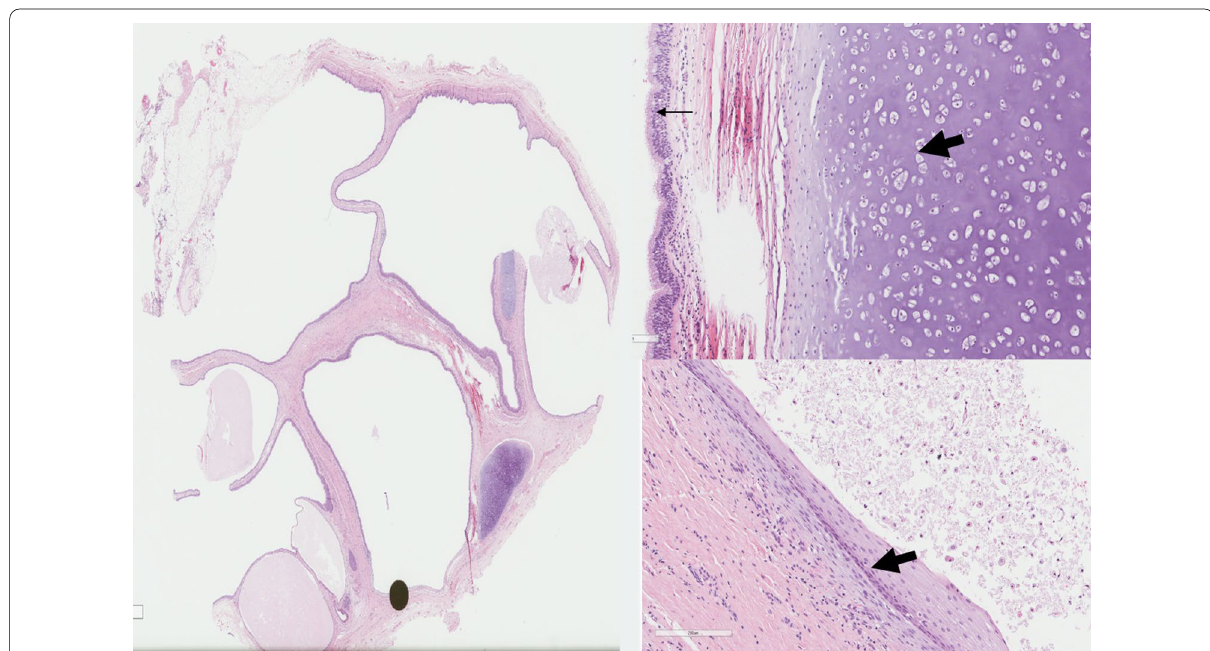
Fig. 5 H&E slide from the lesion showing cystic structure with mixed histological. a Low power magnification shows multicystic lesion lined by epithelium tissue. b Higher power magnification shows cartilage (thick arrow) lined by respiratory type epithelium (thin arrow). c Higher power magnification shows cystic structure lined by squamous epithelium( thick